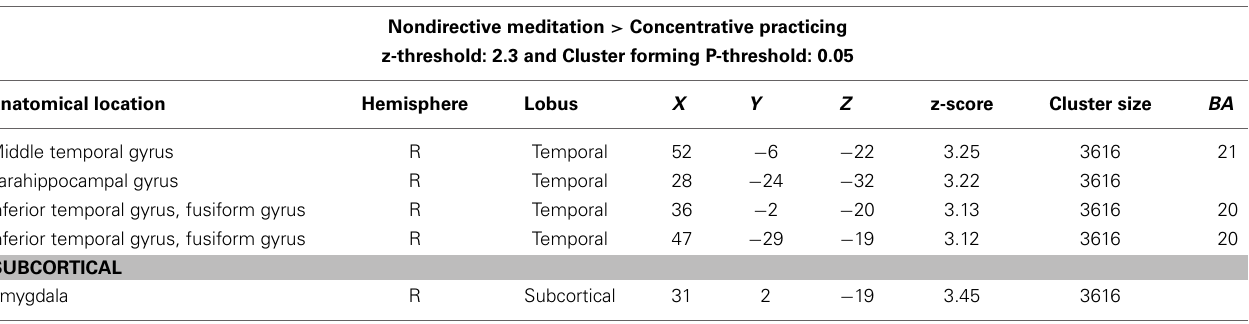
Table 4 | Cerebral regions with increased activity: nondirective meditation > concentrative practicing > rest. Nondirective meditation > Concentrative practicing z-threshold: 2.3 and Cluster forming P-threshold: